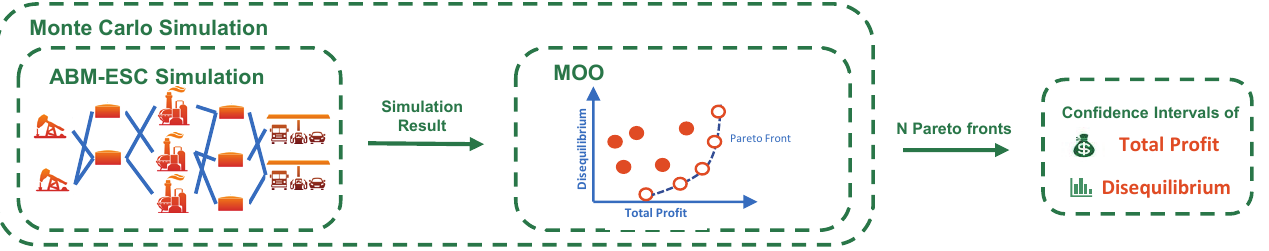
Figure 1. Overall